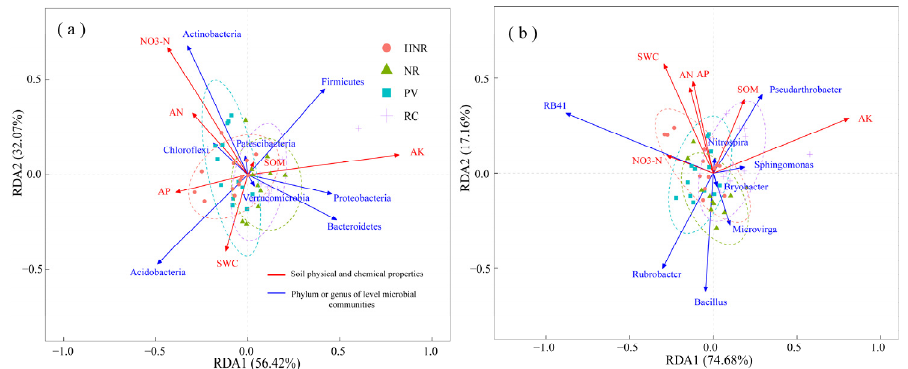
Figure 8. Redundancy analysis of the relationships between microbial communities and the physicochemical properties of soil at the phylum ( a ) and genus ( b ) levels. Circles indicate 95% confidence intervals.